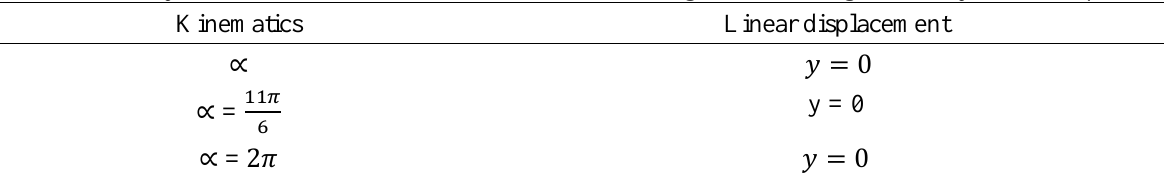
Table 4. Summary of the kinematic motion of the follower during the dwell stage of the cycloid cam